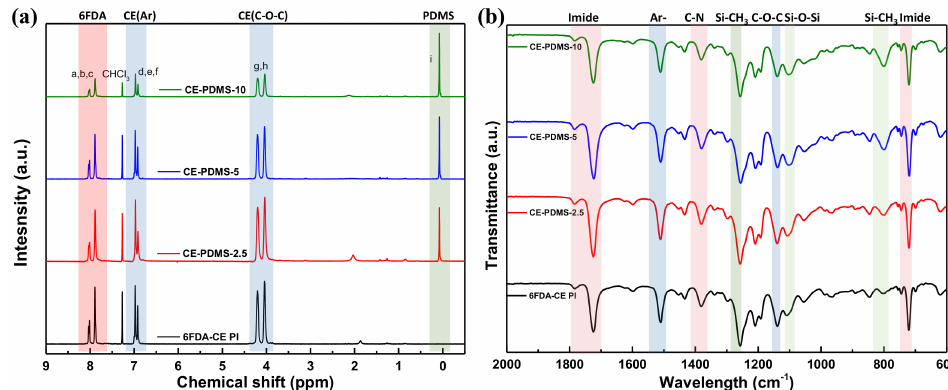
Figure 1. ( a ) 1 H NMR spectra of the low PDMS-content membranes and ( b ) ATR-FTIR spectra of the low PDMS-content membranes at 2000–600 cm − 1